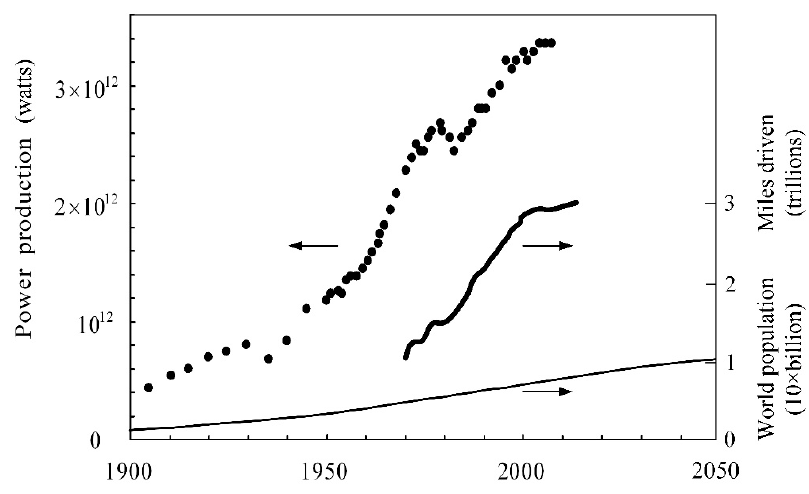
Figure 3. The S-shaped history of power generation in the U. S., the total distance covered annually by vehicles in the U. S., and the world population [17].